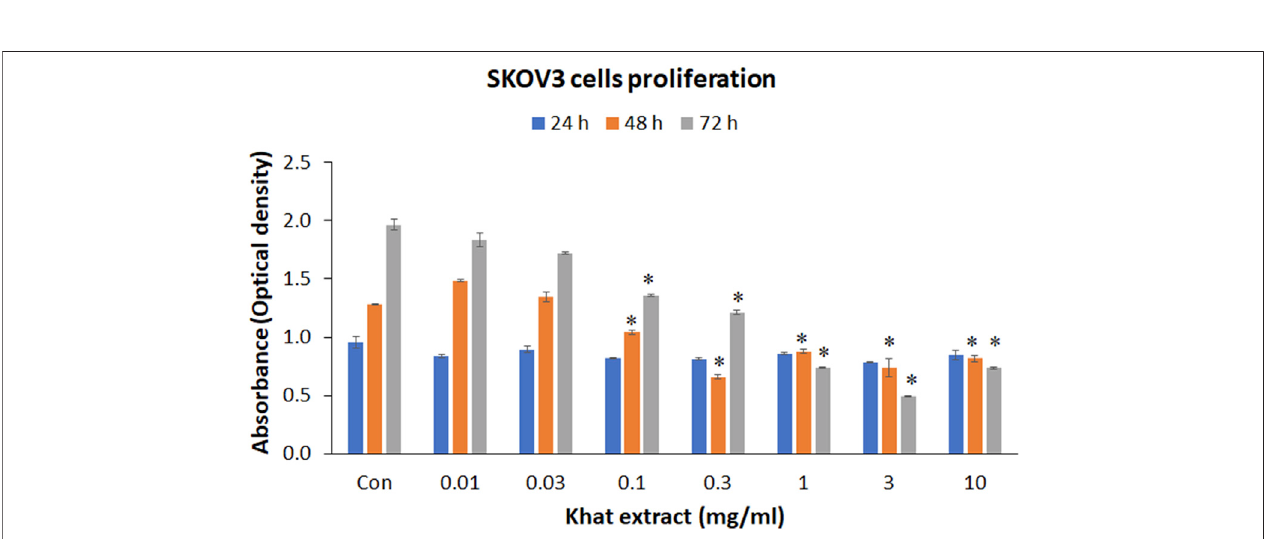
FIGURE2| Cellmetabolicactivity(MTTassay)ofSKOV3followingtreatmentwithkhatextractsatdifferentconcentrations(10,30,100,300 µg/ml;1,3,10 mg/ml) and different time points (24, 48, and 72 h). There was a decrease in cell metabolic activity re fl ecting cell proliferation with increasing concentration of the extract especially at 48 and 72 h compared to the control. Values are expressed as mean ± SEM of three different experiments.*Statistical signi fi cance ( p < 0.05).